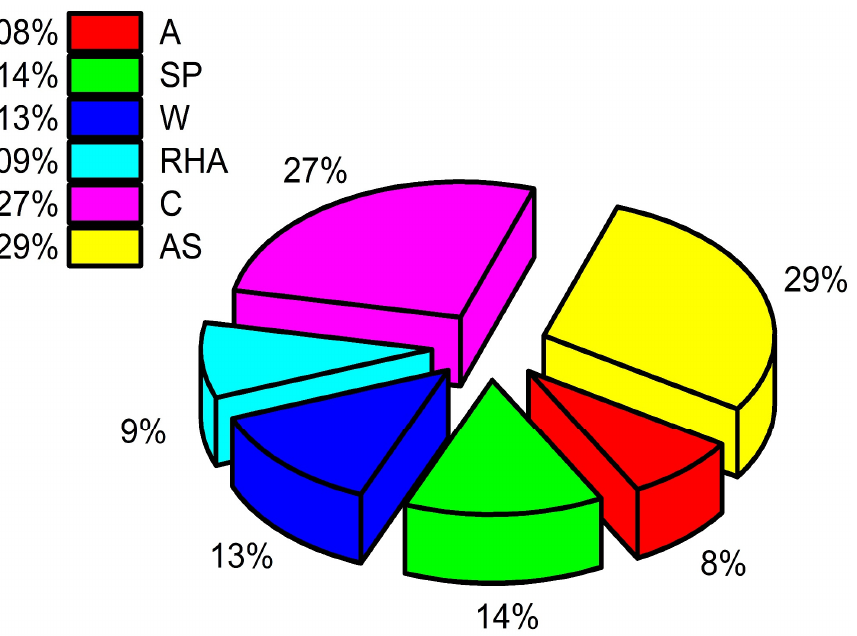
Figure 14. Sensitivity analysis of CRHA concrete.